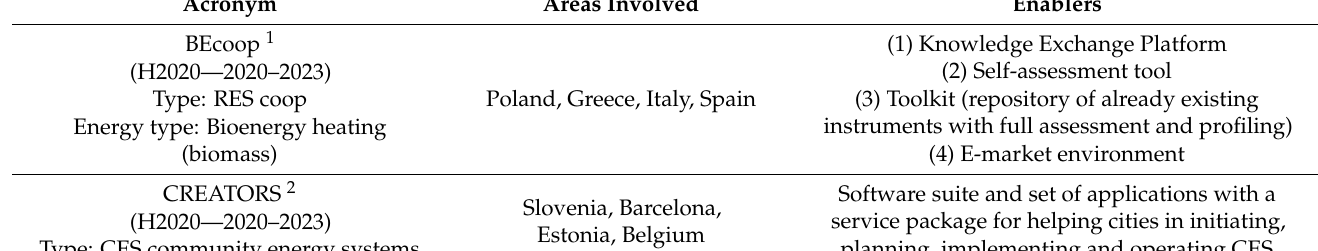
Table 1. Overview of energy communities and energy engagement in some of the most interesting related projects in Europe. Acronym Areas Involved Enablers BEcoop